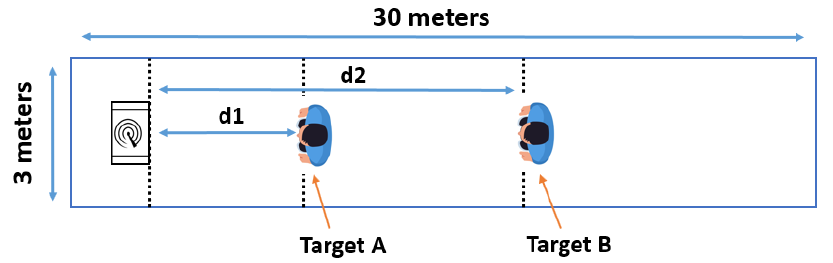
Figure 4. Illustration of the corridor data collection